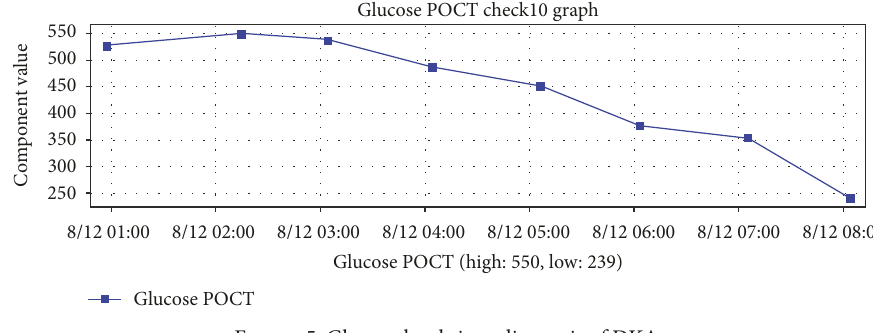
Figure 5: Glucose level since diagnosis of